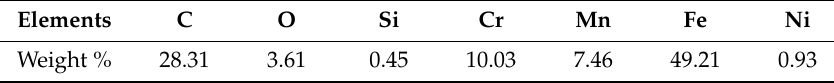
Figure 20. EDS / SEM spectrum analysis of fracture face of ATIG heat a ff ected zone. Table 13. Elements present in fracture face of TIG heat a ff ected zone. Table 14. Elements present in fracture face of ATIG heat affected zone. Elements C